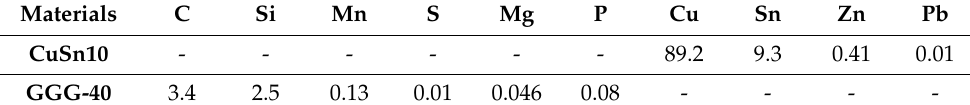
Table 1. Chemical composition of matrix and reinforcement materials at wt% [28,53].